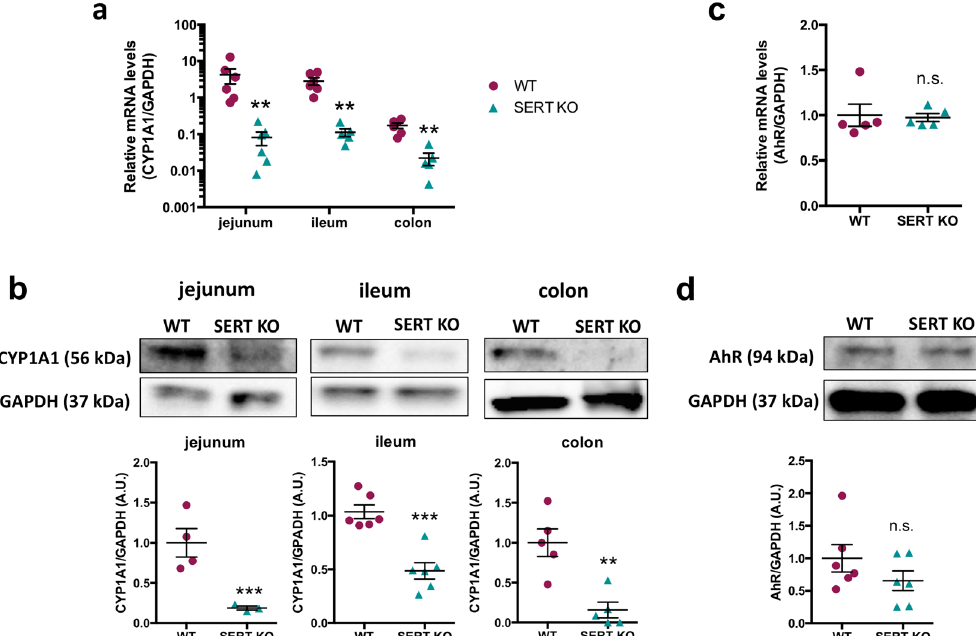
Figure 7. CYP1A1 expression is suppressed along the intestine of SERT KO mice. ( a ) Total RNA was isolated from intestinal mucosal scrapings from WT and SERT KO mice. Data represent the relative expression of CYP1A1 mRNA quantified by qPCR. Data analyzed by Mann-Whitney U test ( n = 5–6). ** P < 0.01 vs. WT. ( b ) Protein lysates were prepared from intestinal mucosal scrapings from WT and SERT KO mice. CYP1A1 protein was measured by Western blot and normalized to GAPDH ( n = 4–6). Full-length blots are shown in Supplementary Figure S2. ( c ) Total RNA was isolated from ileal mucosal scrapings of WT and SERT KO mice. Data represent the relative expression of AhR mRNA quantified by qPCR. ( d ) AhR protein was measured in the ileal mucosa by Western blot. Densitometric analysis of relative band intensities expressed as arbitrary units. Full-length blots are shown in Supplementary Figure S2. Data analyzed by 2-tailed unpaired Student’s t -test ( n = 4–6). ** P < 0.01, *** P < 0.001. n.s. = not significant. Magenta circle = WT, turquoise triangle = SERT